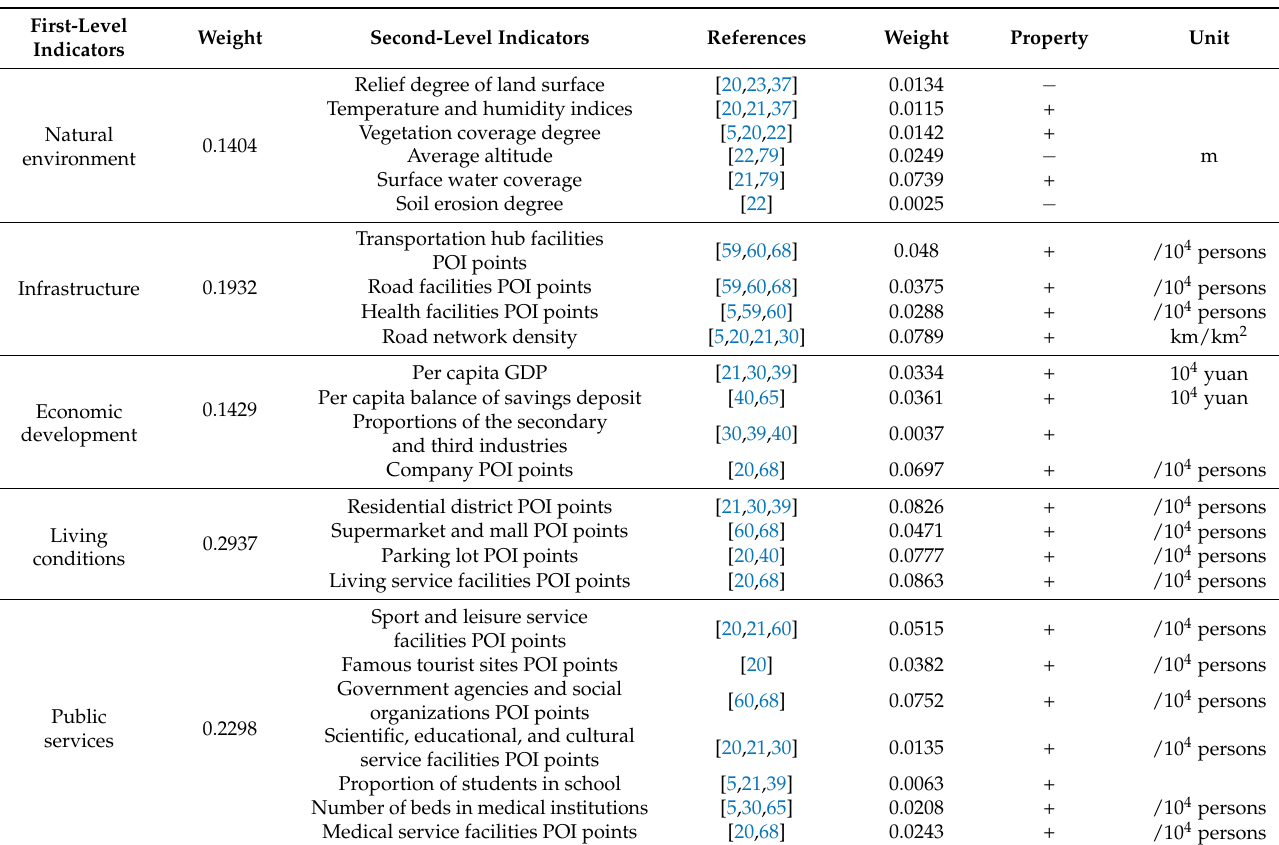
Table 1. Quality evaluation index system for human settlements in the Qinghai–Tibet